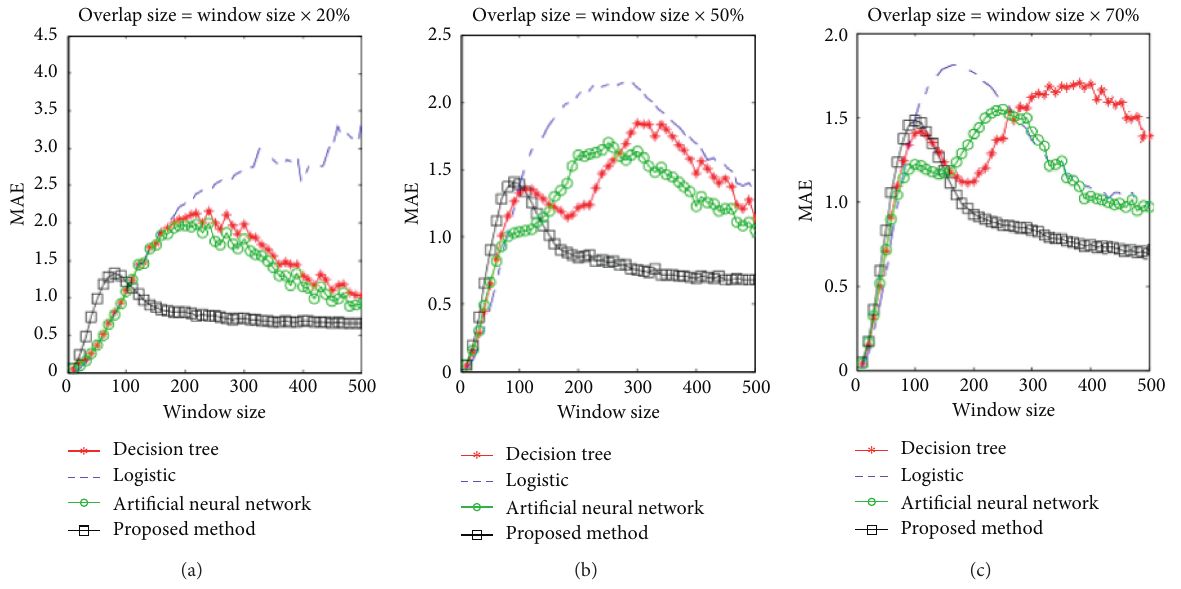
Figure 6: Detection performance of each classifier under different overlapping window size units: